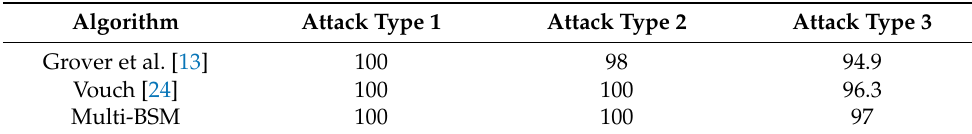
Table 6. Comparison of accuracy rate in high vehicle